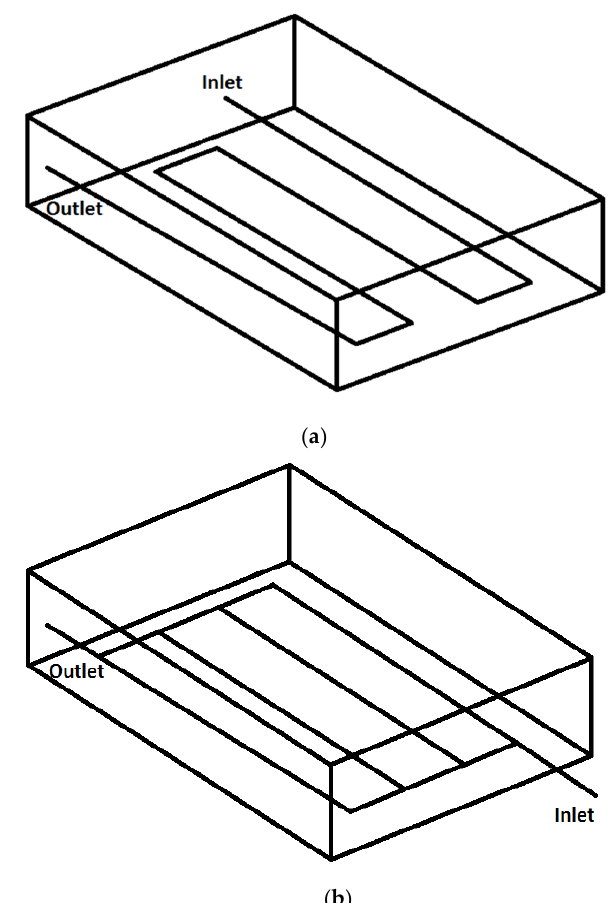
Figure 3. Configurations of multiple pipes EAHE. ( a ) Series; ( b ) Parallel.